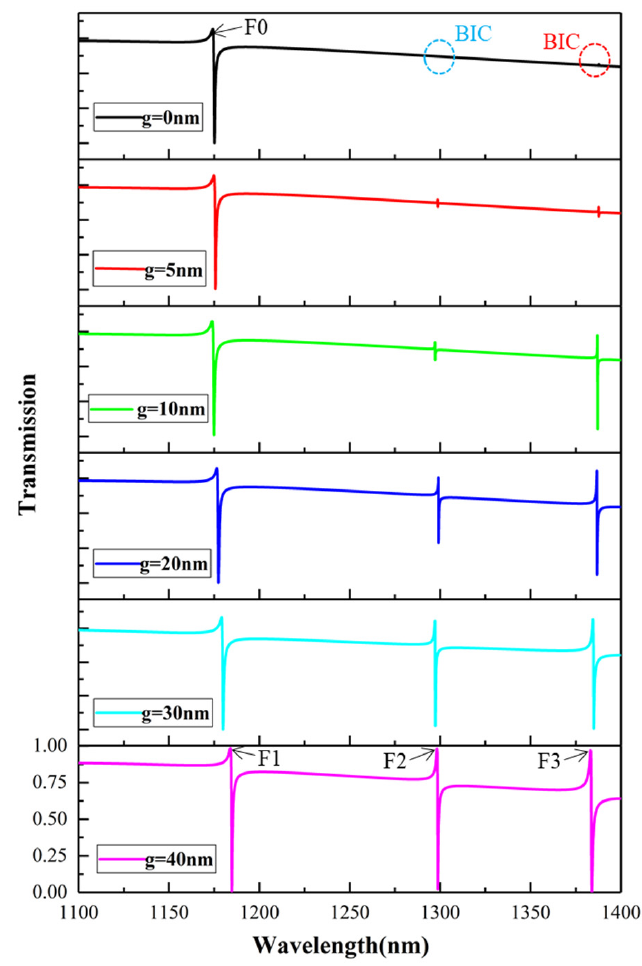
Figure 2. Transmission spectra of the SHND nanostructure with different asymmetry parameters.